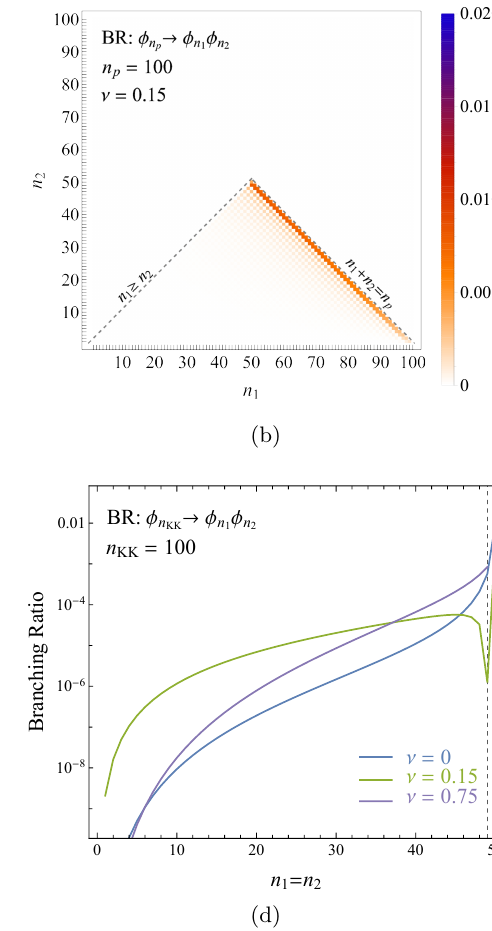
Figure 4 . (a–c) Branching ratios, for ν = { 0 , 0 . 15 , 0 . 75 } , of the 100 th KK mode into all kinemati- cally allowed two-body final states, as a function of the daughter KK-numbers n decays occur at or near kinematic threshold, along the line of minimum KK violation. The pro- jection of the branching ratios for all values of ν on the n relative suppression of KK violation is made obvious especially for the ν = 0